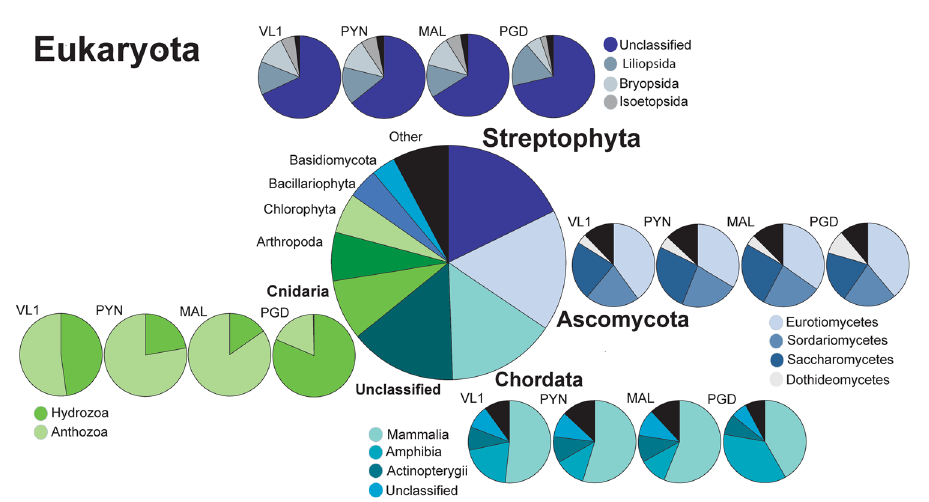
Figure 2. Taxonomic structure and diversity of the reads mapping to Archaea . Kingdom, phyla and class divisions across the four sampling locations in Kerala, India, with class divisions noted across the top three phyla.